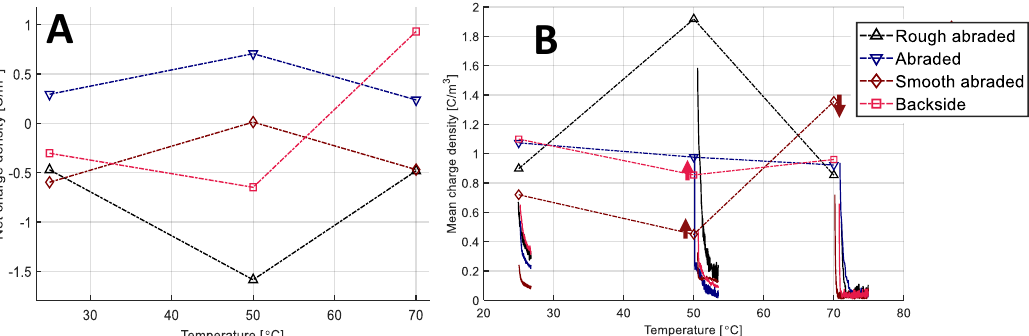
Figure 11. Impact of temperature at +15 kV poling, using different temperatures, on the net charge density ( A , left) and the mean charge density ( B , right). The indicated surface types were used as positive anode, while the cathode was a backside type surface in all experiments. Markers indicate the value in the end of the polarization. The solid lines in ( B ) show the mean charge density against time during depolarization. Dashed lines indicate trendlines. The arrows in ( B ) indicate probable corrections for thickness (poling field) deviations.